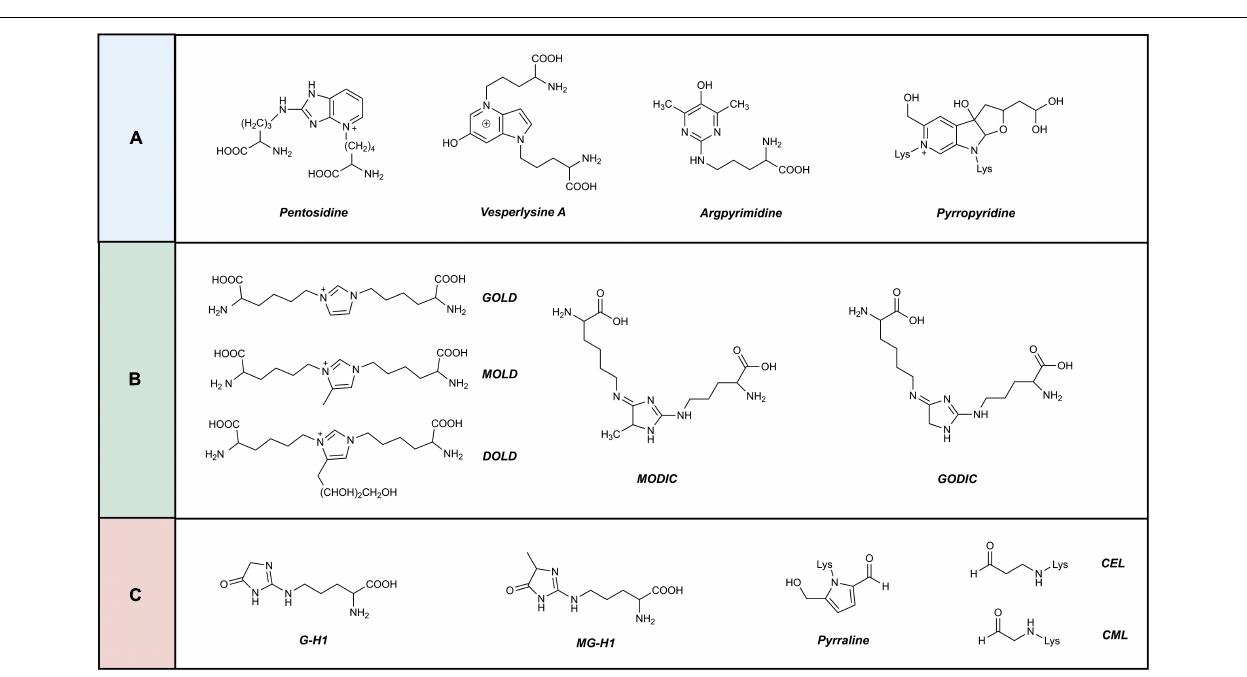
FIGURE 2 | Classification of advanced glycation end products. AGEs are classified according to their crosslinking structure and fluorescence characteristics into three categories. (A) Fluorescent, cross-linked. (B) Non-fluorescent, cross-linked. (C) Non-fluorescent,